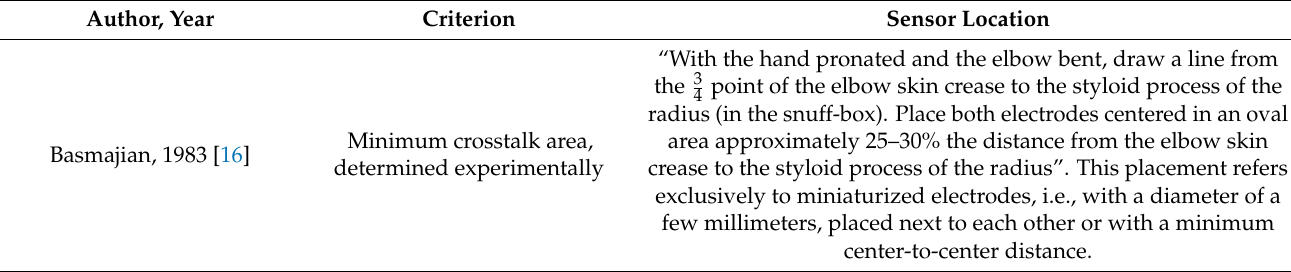
Table 2. Reference guidelines available in literature for sensor location on the brachioradialis muscle, when assessed by bipolar